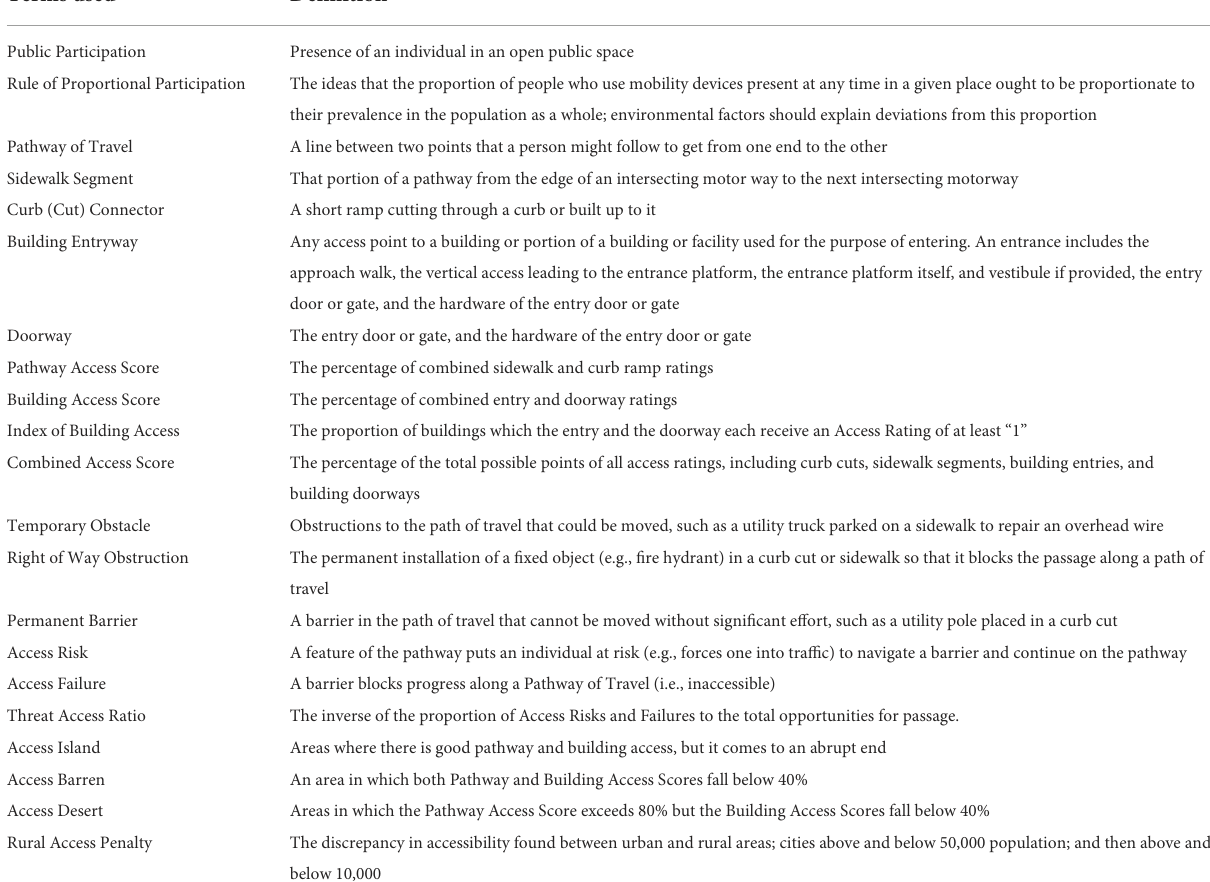
TABLE 1 Definitions of selected terms and